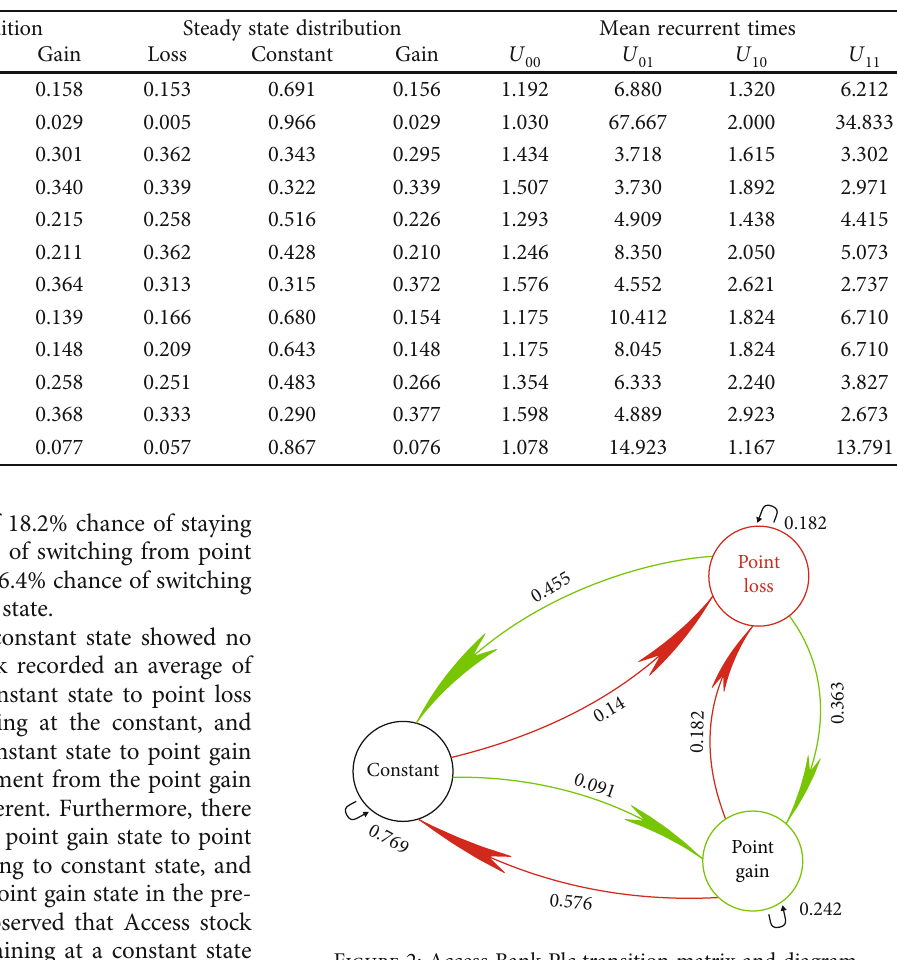
Table 2: Summary statistics for initial market condition, steady-state distributions, and mean recurrent times.